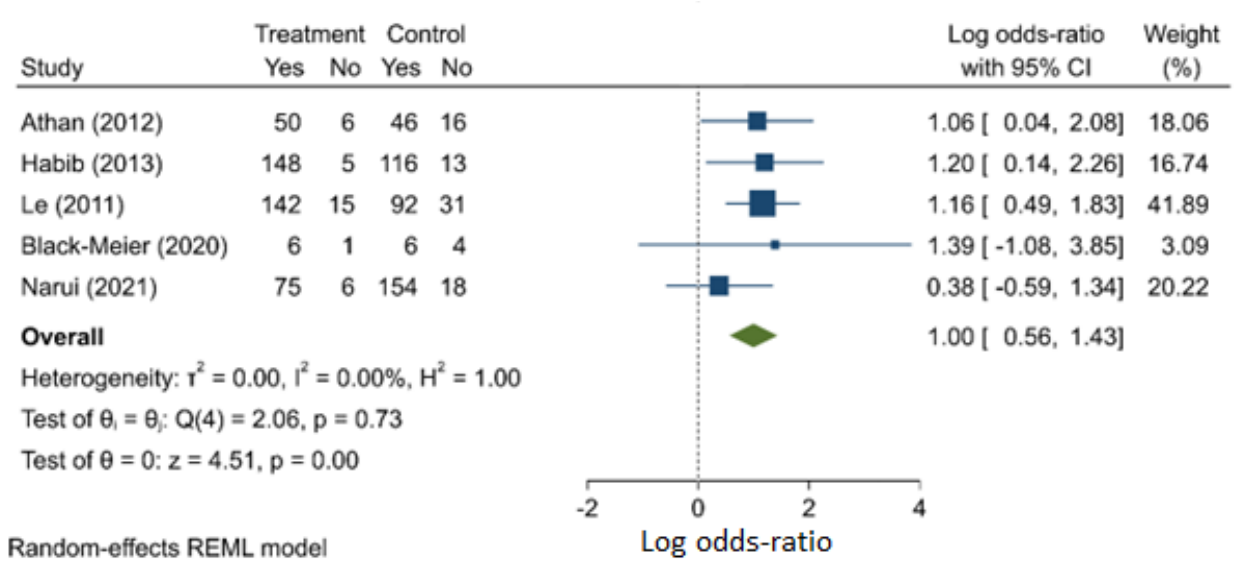
Figure 2. Staphylococcus aureus compared with non- Staphylococcus aureus CIED infection as a risk factor for mortality.